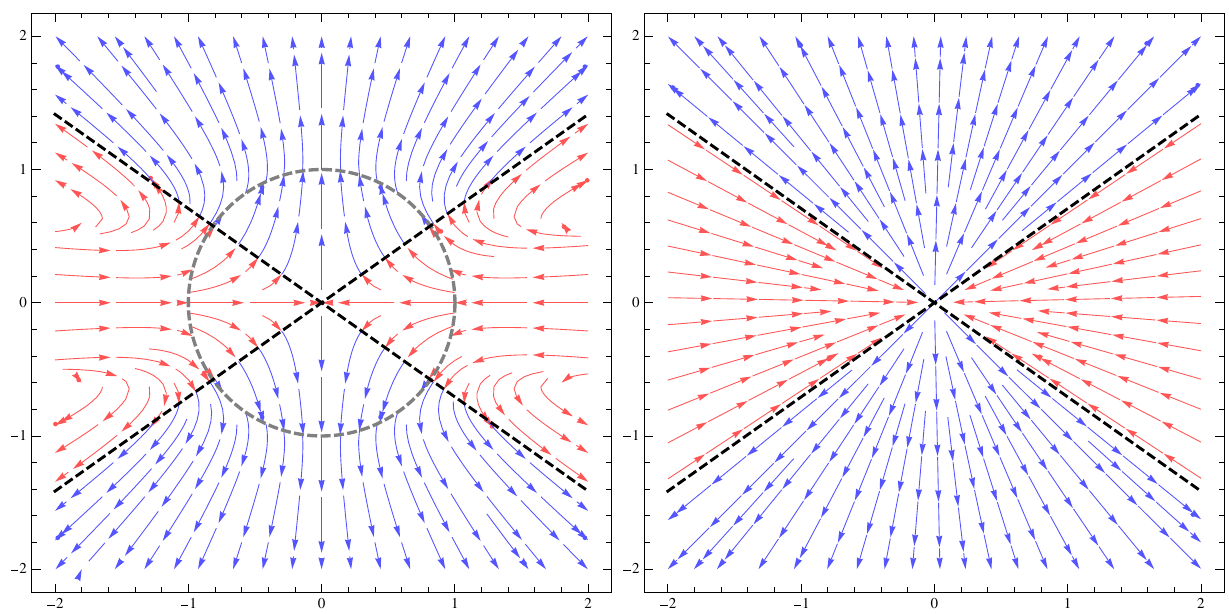
the red/blue arrows in the left pattern tend to straight lines, becoming “inward” and “outward” magnetic lines of force, as depicted in the right pattern. The inclined dashed lines indicate regions of zero magnetic field on the right, whereas, on the left, they only divide “inward” and “outward” magnetic lines of force in the limit R →